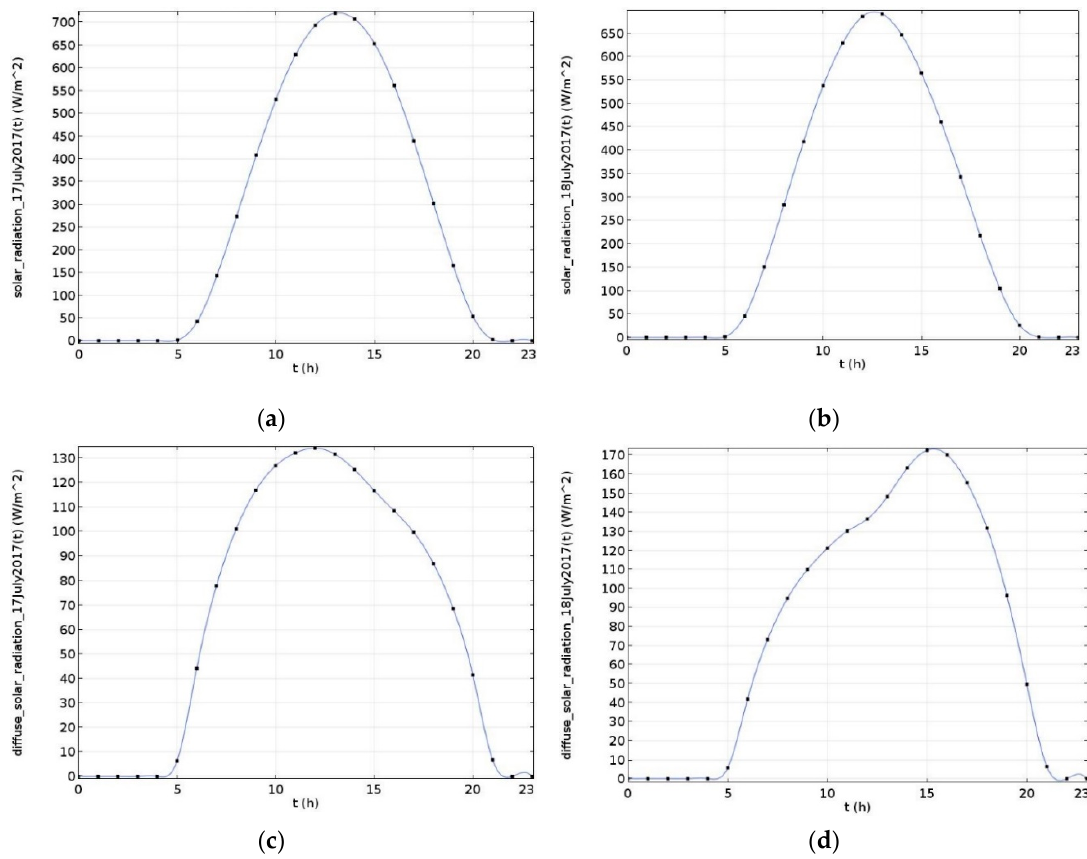
Figure 8. Solar radiation subdivision: ( a ) Beam Horizontal Irradiation (BHI) on 17 July 2017; ( b ) BHI on 18 July 2017; ( c ) DHI on 17 July 2017; ( d ) DHI on 18 July 2017.